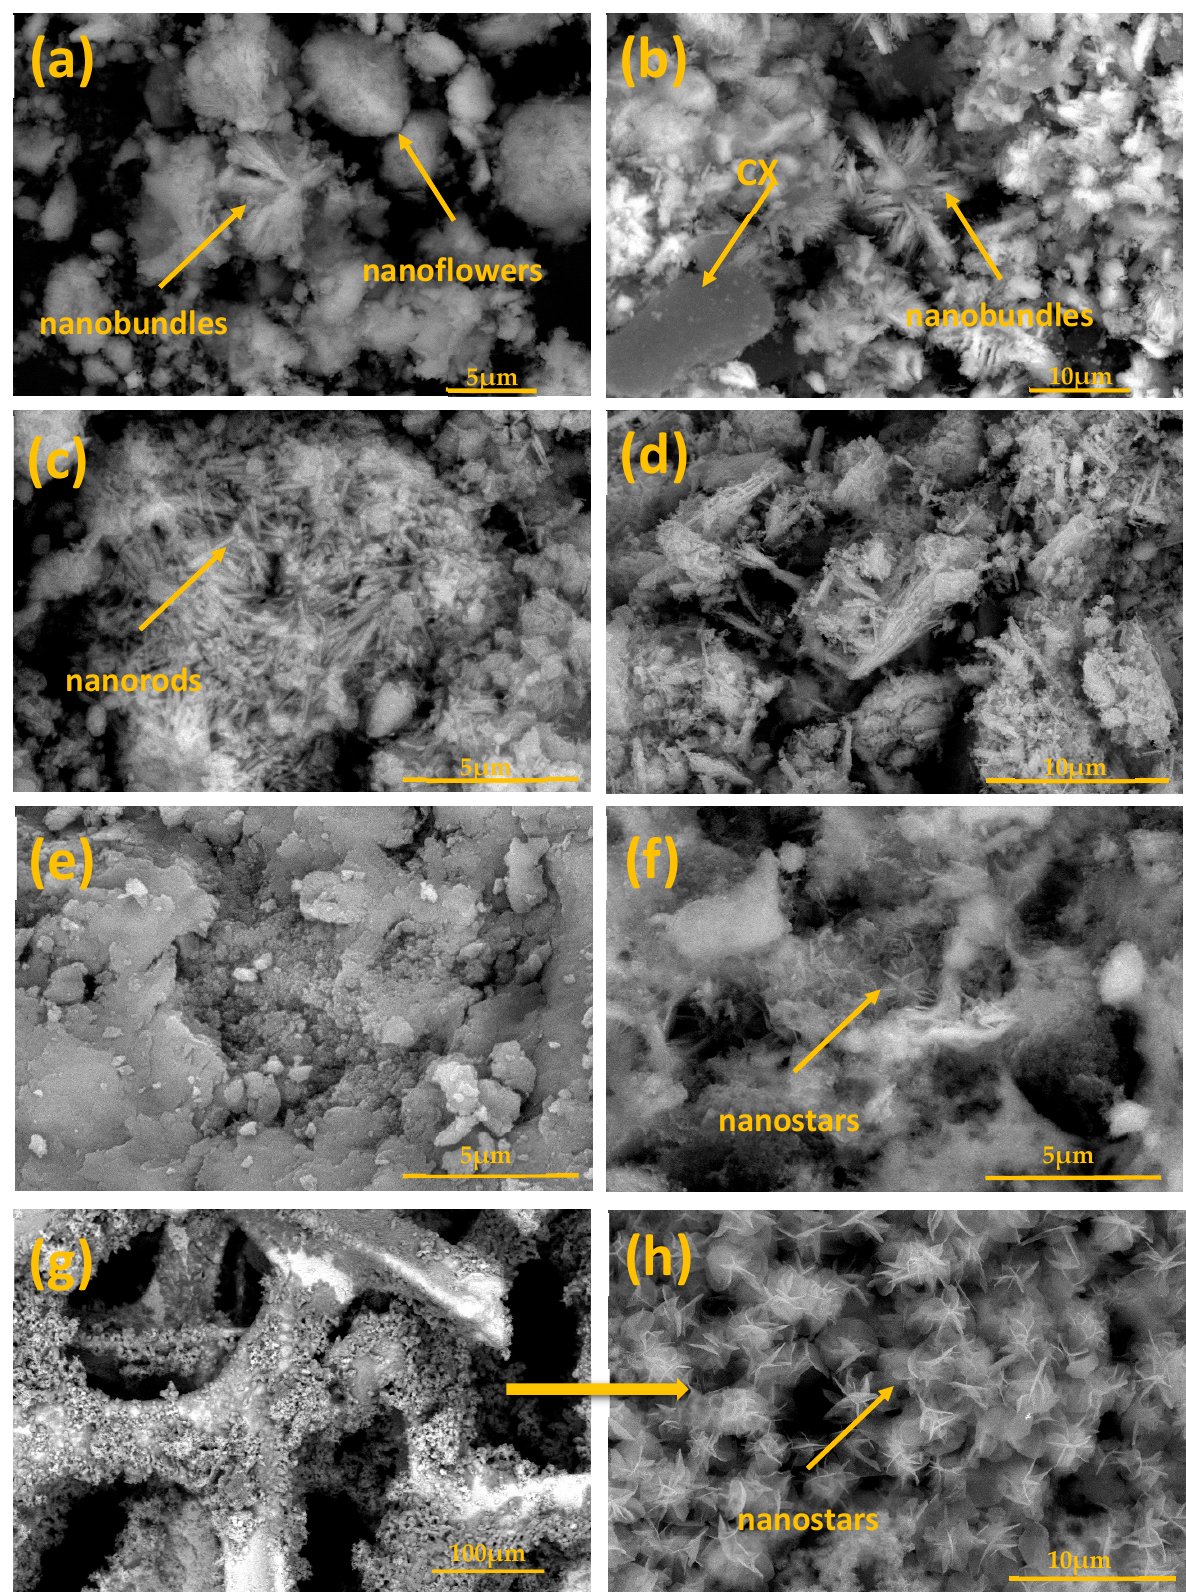
Figure 2. SEM images of ( a ) ZnFe-LDH, ( b ) ZnFe-LDH/CX, ( c ) CoFe-LDH, ( d ) CoFe-LDH/CX, ( e ) NiFe-LDH, ( f ) NiFe- LDH/CX, and ( g , h ) NiFe-LDH/CX/NF.